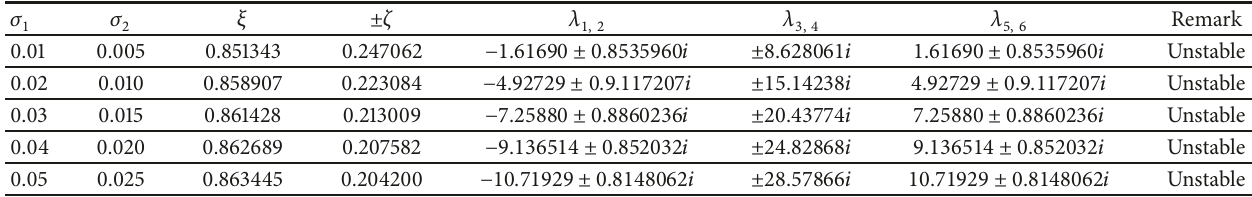
Table 7: Effects of triaxiality of DP-Leonis on the locations and stability of out-of-plane points for 𝑎 = 0.95, 𝑒 = 0.2 and 𝐴 = 0.02